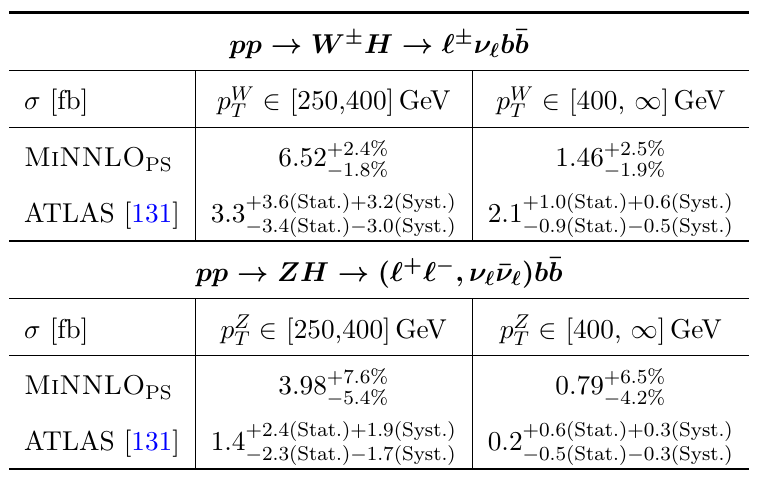
Table 4 . Fiducial cross sections in the fiducial-ATLAS setup compared to